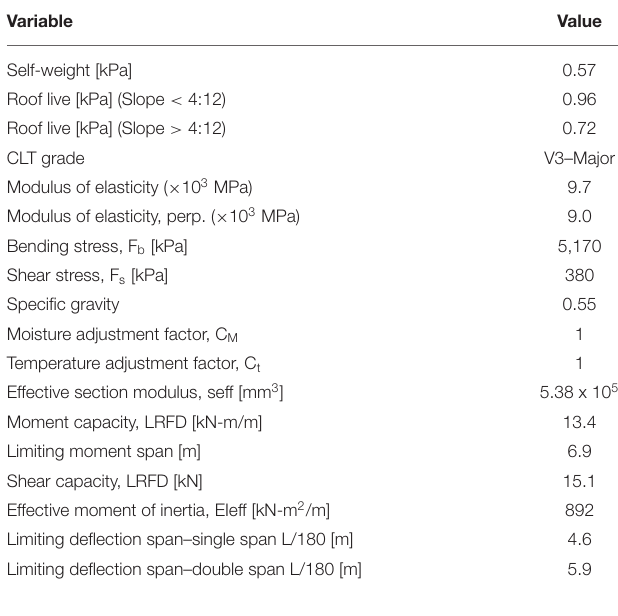
TABLE 2 | Material properties used for structural design of CLT elements.